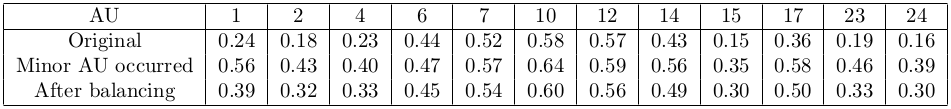
Table from the paper: EAC-Net: A Region-based Deep Enhancing and Cropping Approach for Facial Action Unit Detection
Table text:
AU
1
2
4
6
7
10
12
14
15
17
23
24
Original
0.24
0.18
0.23
0.44
0.52
0.58
0.57
0.43
0.15
0.36
0.19
0.16
MinorAUoccurred
0.56
0.43
0.40
0.47
0.57
0.64
0.59
0.56
0.35
0.58
0.46
0.39
Afterbalancing
0.39
0.32
0.33
0.45
0.54
0.60
0.56
0.49
0.30
0.50
0.33
0.30